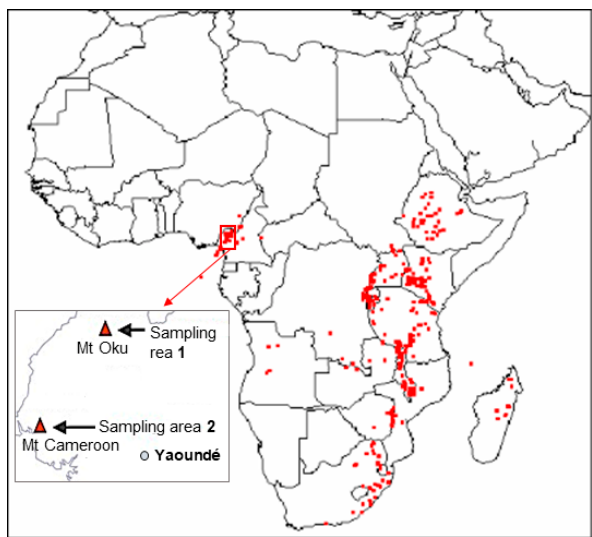
Fig. 1. Global distribution of P. africana according Hall et al. (2000) with geographic position of collection sites in Cameroon